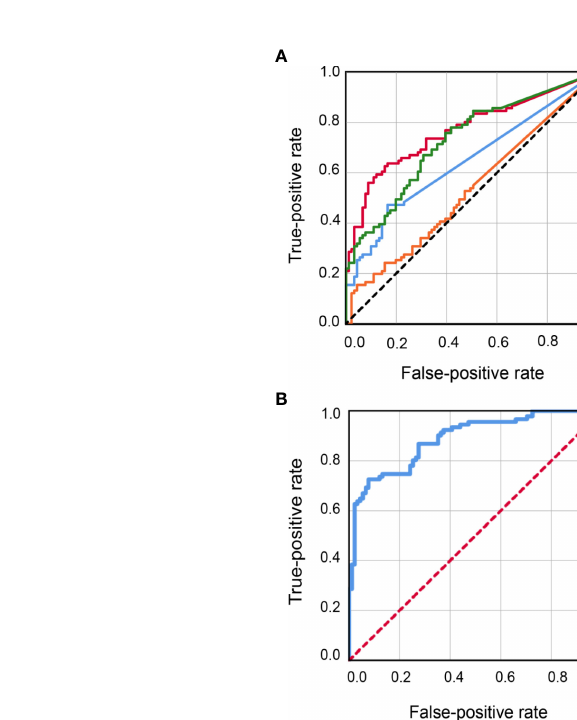
FIGURE 4 Receiver-Operator Curve plots of microbial markers for distinguishing CD patients from healthy controls. (A) Models with individual genus marker. (B) Model with combined genus marker. AUC, area under the